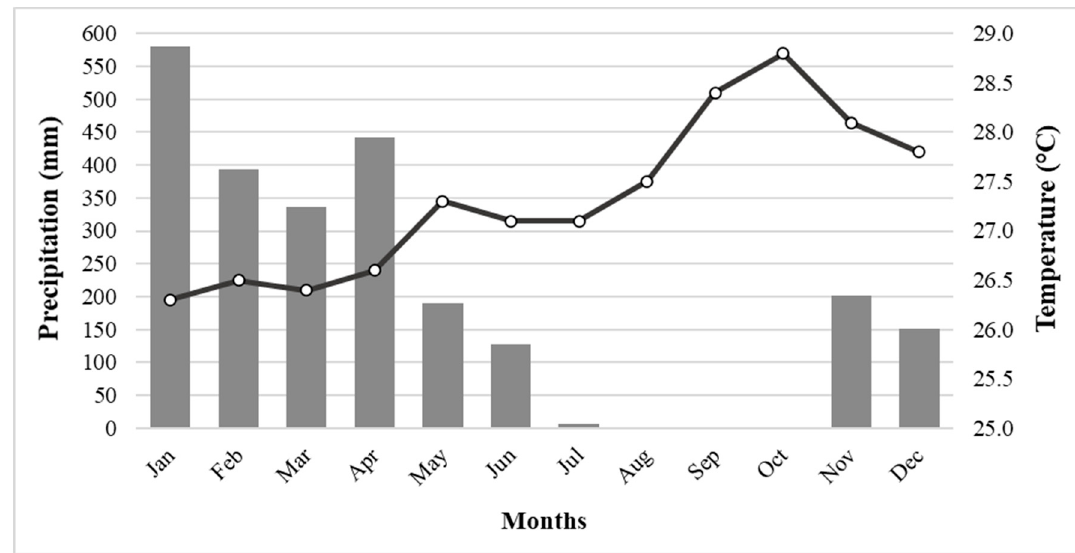
Figure 2. Precipitation, and the minimum and maximum temperatures for each month during the study. Source: INMET, 2021 [22].